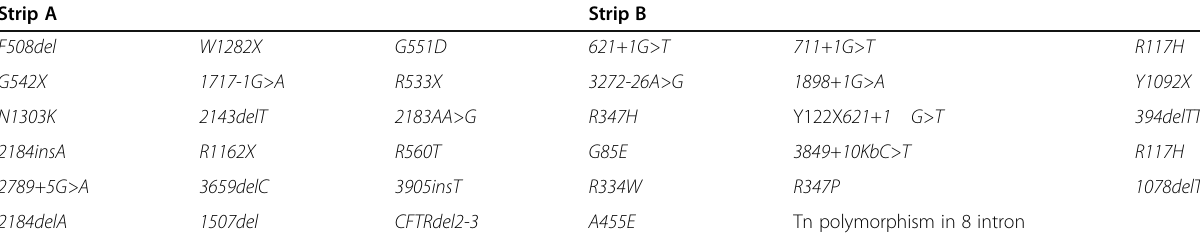
Table 2 Pathogenic variants that were analyzed by a kit from ViennaLab Diagnostics GmbH, Austria Strip A Strip